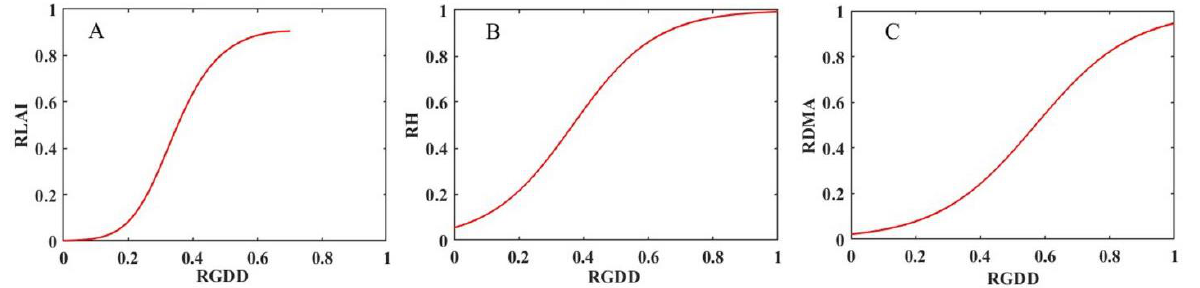
Figure 7. Comprehensive and fully relative logistic curves of the indices of growth for the four crops between ( A ) RLAI and RGDD, ( B ) RH and RGDD, and ( C ) RDMA and RGDD. Five sets of unmodelled data for each crop were used to evaluate Equation (11). Scat- ter plots between the measured and fitted values are shown in Figure 8. This comprehen- sive fully relative logistic model fitted the indicators well ( R 2 > 0.75, RMSE < 0.15, RE < 5%) except for RLAI for summer maize and cotton (Figure 8D,J). Equation (11) can therefore describe the growth of the crops well.